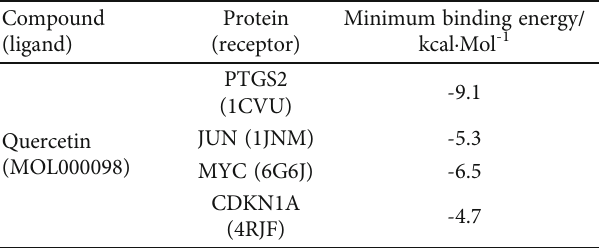
Table 3: The results of molecular